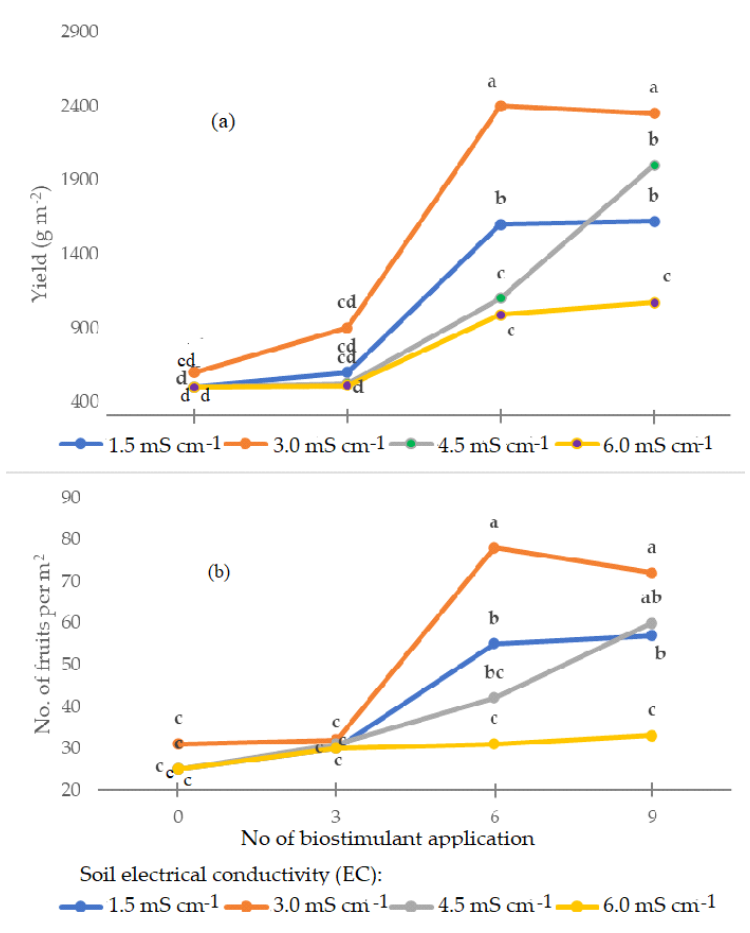
Figure 1. Yield ( a ) and number of fruits per m 2 ( b ) of tomato (Proxy F 1 ) affected by the interaction between soil EC and the number of biostimulant applications during the spring – summer season. Within each parameter, the values followed by different letters are statistically different according to Duncan’s multiple range test at p ≤ 0.05.